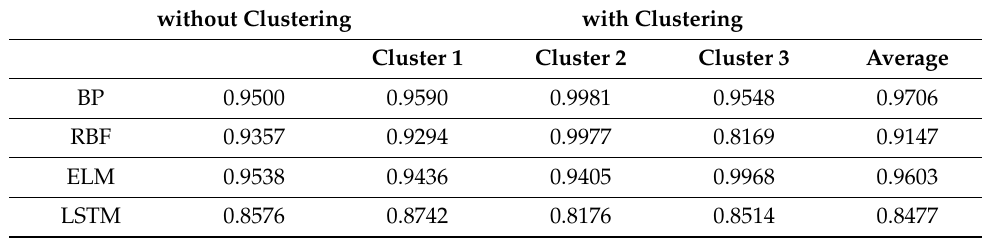
Table 10. R 2 of solar radiation in summer.